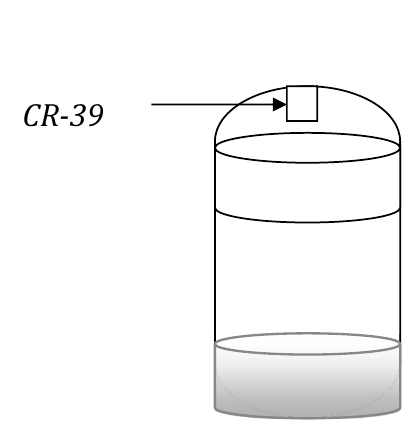
Fig. 2 CR-39 Set up in Chamber Cover